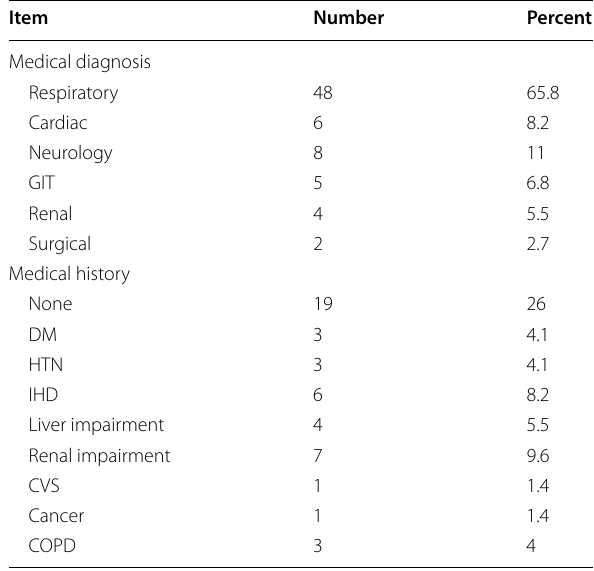
Table 1 Percentage distribution of the studied patients in Table 2 Frequency distribution of the sample according to their relation to their characteristics ( N 73) =